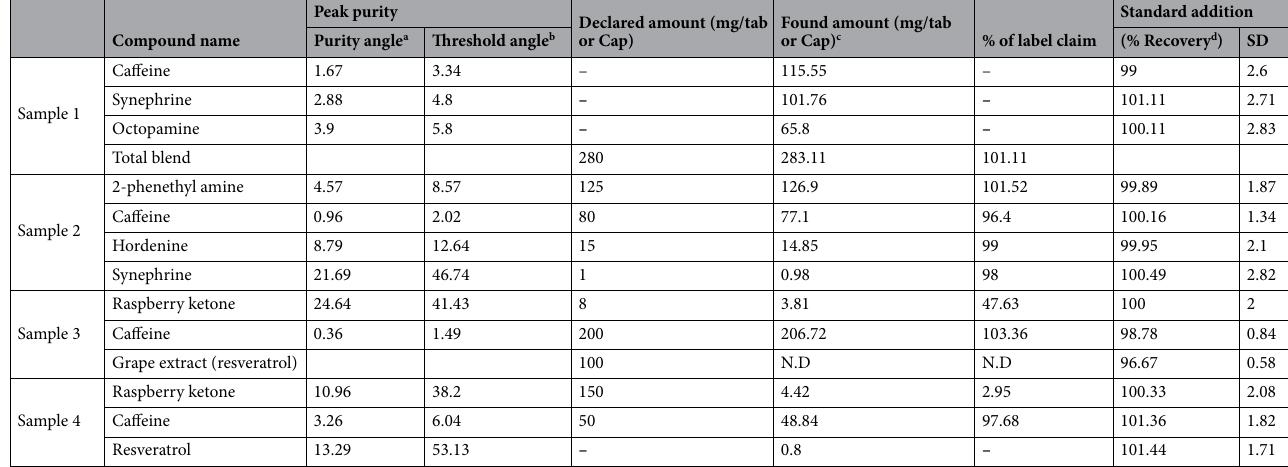
Table 4. Assay and standard addition results of commercial dietary supplement samples using the proposed HPLC method. a Purity angle compares spectrum of each point in the peak to the peak apex spectrum. b Purity threshold: solvent angle + noise angle. c Average of three determinations. d Average of three determinations on three concentration levels. –Ingredients were labeled as proprietary blends without stating the exact amount of each. N.D. not detected below